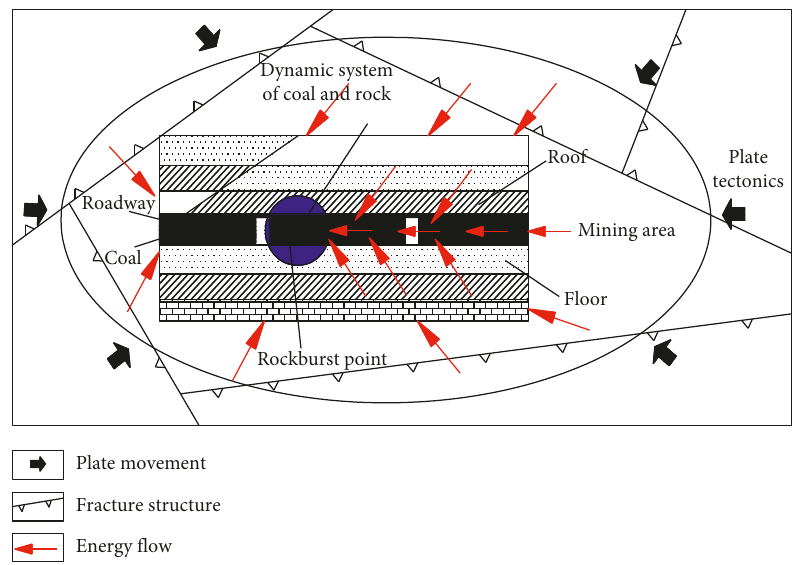
Figure 2: Energy sources of coal dynamic